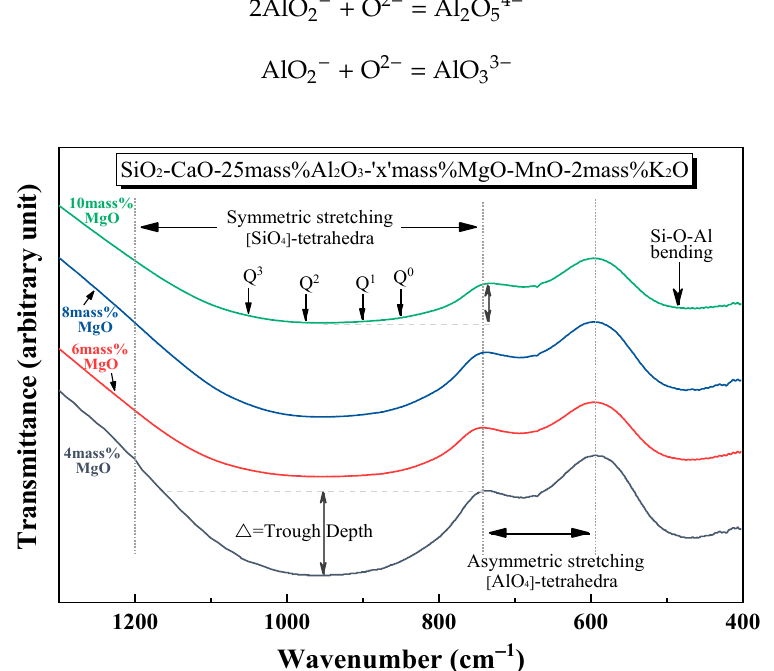
Figure 6. The effect of the MgO on the FTIR spectra of SiO 2 –CaO–25 mass% Al 2 O 3 –MnO–MgO–2 Figure 6. The e ff ect of the MgO on the FTIR spectra of SiO 2 –CaO–25 mass% Al 2 O 3 –MnO–MgO–2 mass% K 2 O slag. mass% K 2 O